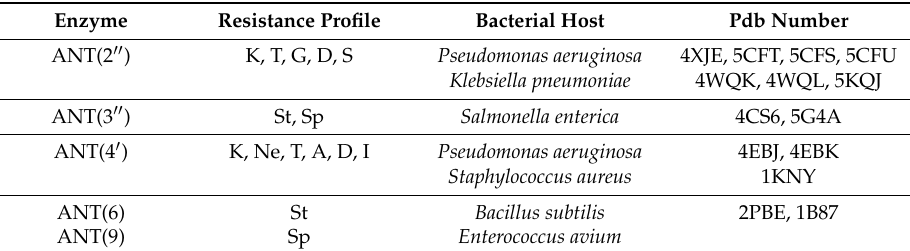
Table 3. O -nucleotidyltransferase (ANT)-modifying